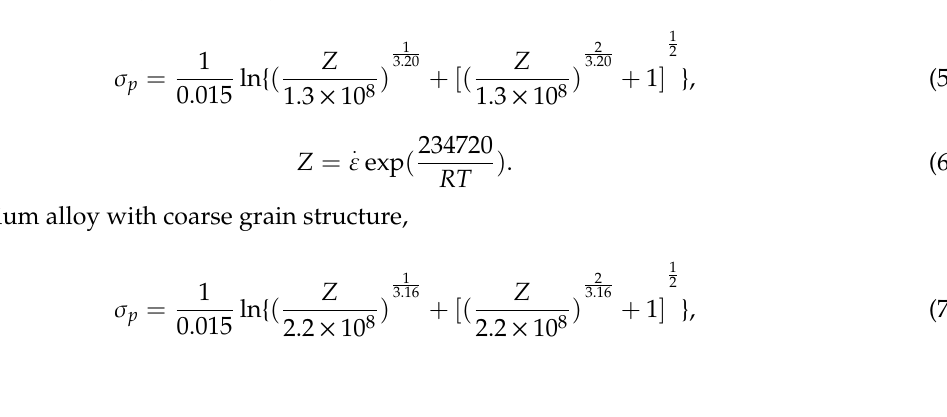
Figure 7. Variation in the peak stress ( σ p ) with the Z parameter for the TB8 titanium alloys with two different initial grain sizes in the single β phase field.